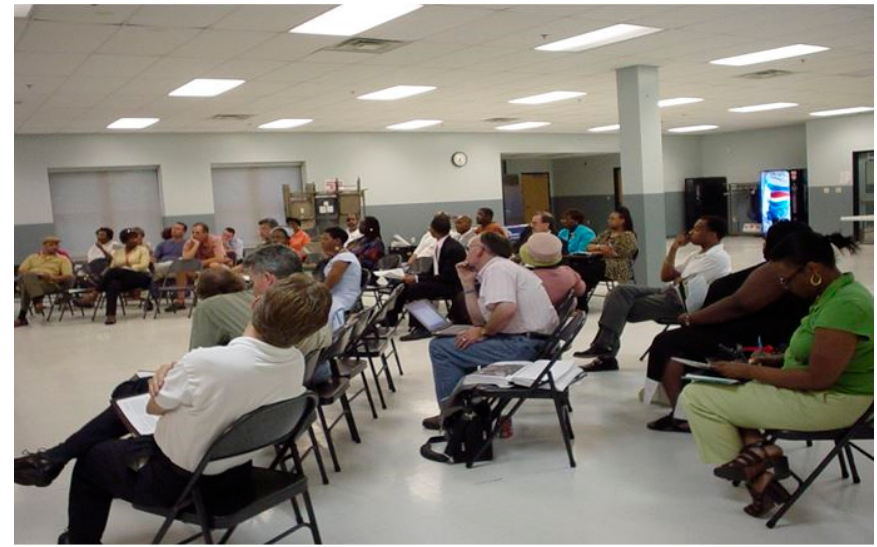
Figure 3. Community members attending a public meeting to discuss remediation plans.